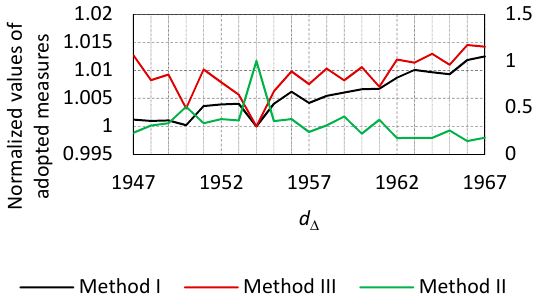
Figure 7b as a Primary Image, Monitor Mode 1280 × 1024/60 Hz, Pre-Estimated Value